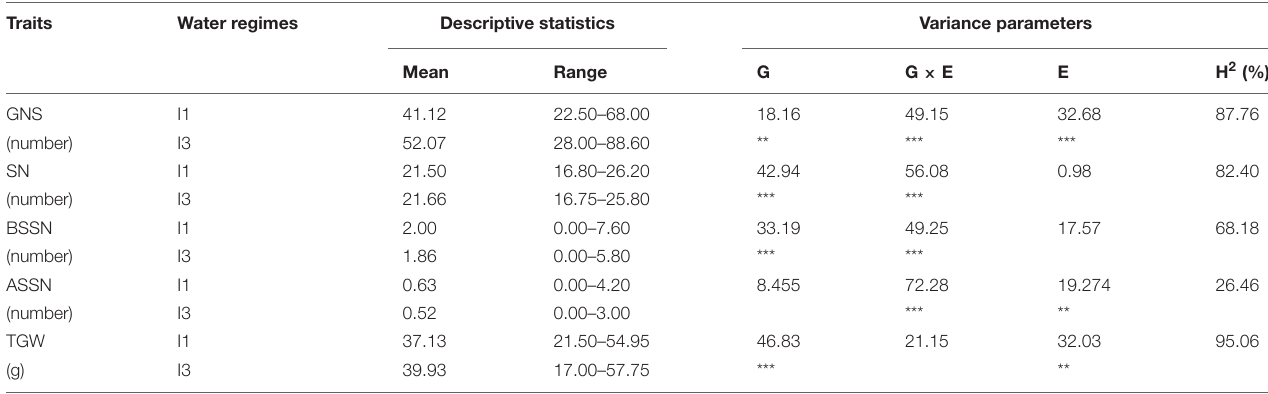
TABLE 1 | Analysis of variance in SN, GNS, BSSN, ASSN, and TGW of wheat under different irrigation conditions (I1 and I3) during the 2019–2020 and 2020–2021 growing seasons. Traits Water regimes